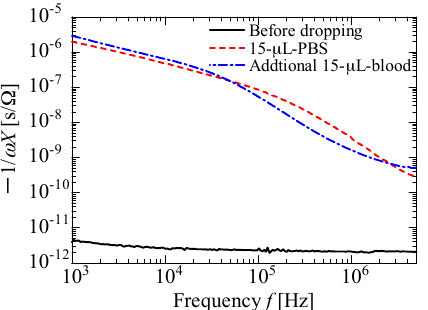
Figure 4. Sensor values of − 1/ ω X as a function of frequency f obtained before and after dropping 15 μ L of PBS, and after dropping an additional 15 μ L of blood.